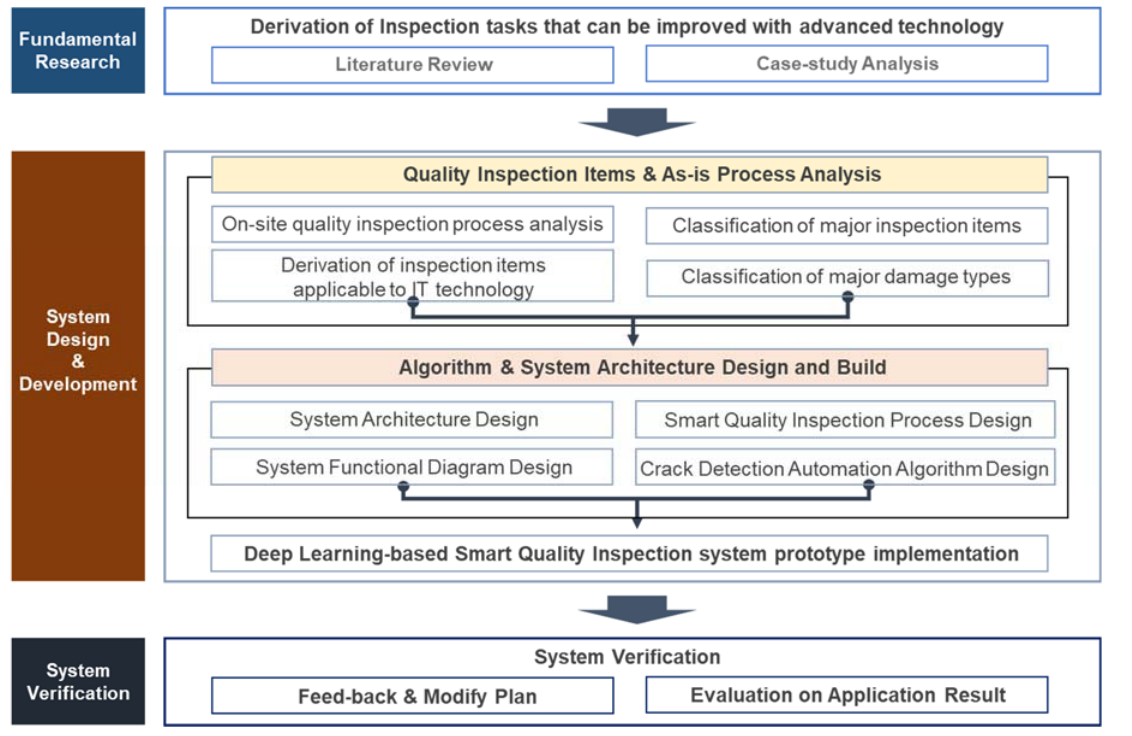
Figure 1. Research methods and procedures.